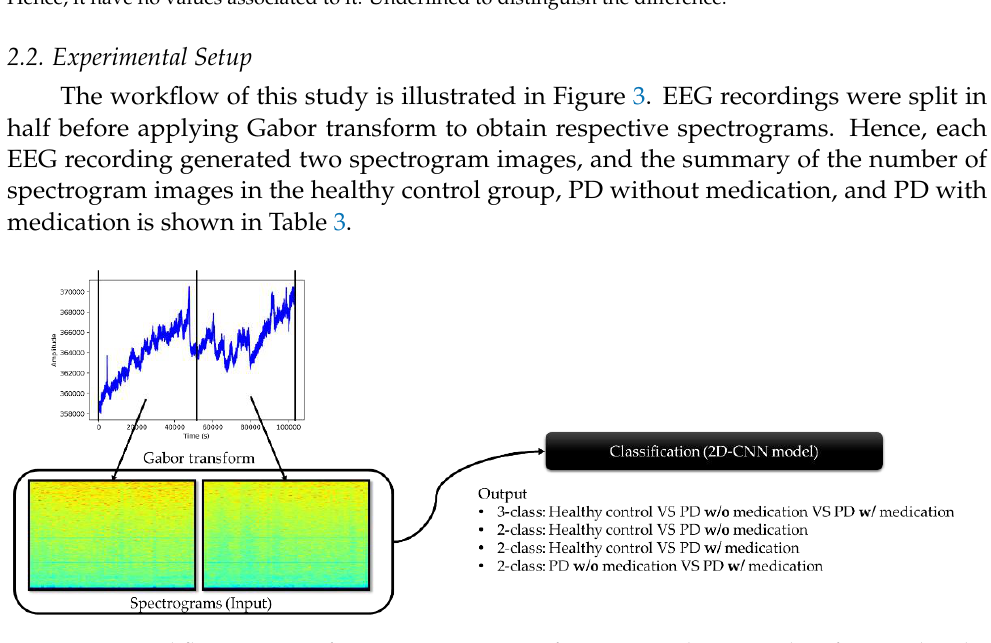
Figure 3. Workflow process from preprocessing of EEG recordings to classification by the proposed model. Table 3. Number of spectrograms generated for the respective groups.